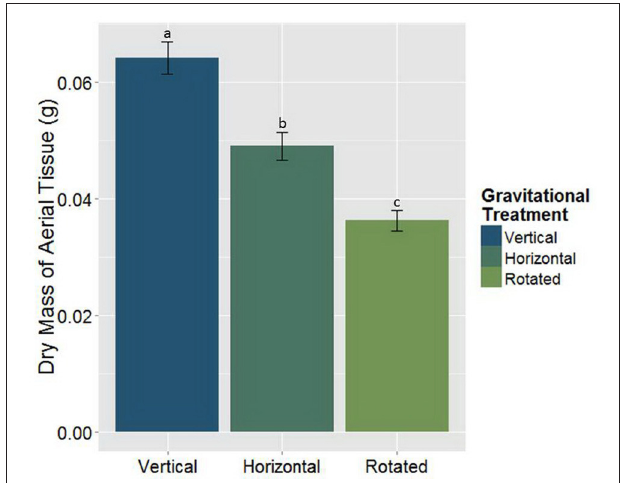
FIGURE 2 | The main effect of the gravitational treatments on the above-ground dry biomass in M. truncatula ( n = 186 , p < 0.05 ). The letters above each standard error bar denote significance between the gravitational treatments. Treatments with the same different letters are significantly different. Clinorotation significantly reduces the above-ground mass of M. truncatula (p < 0.05).